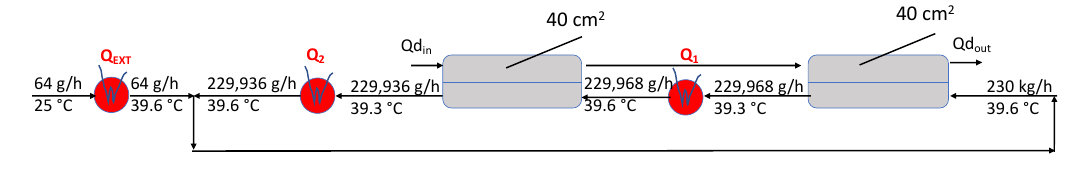
Figure 9 . DCMD – DCMD flowsheet. Figure 9. DCMD–DCMD